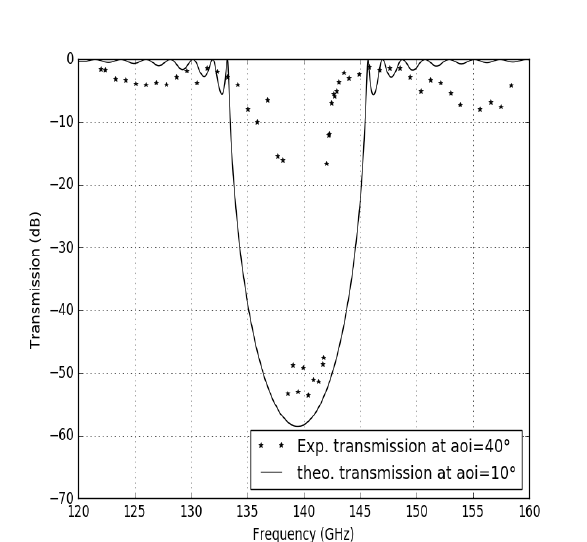
FIG. 7. Experimental transmission characteristics of the notch